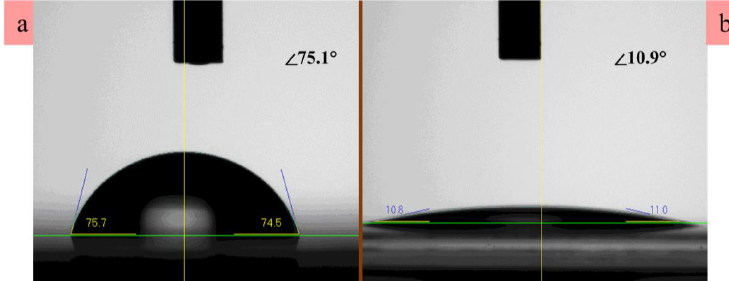
Figure 2. The contact angle measured ( a ) before and ( b ) after oxygen plasma treatment on the surface of the PET substrate. Cross-sectional views and surface morphologies of the NRs were examined by field-emission scanning electron microscopy (FE-SEM, 15 kV, Hitachi 4800S). The crystallinity and preferred